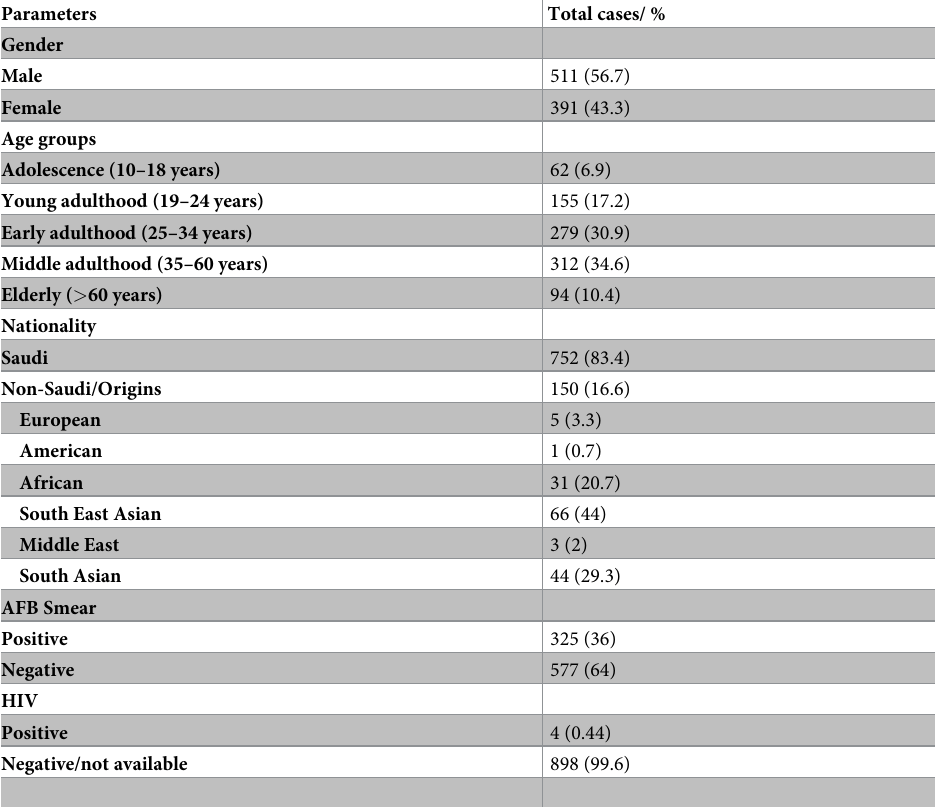
Table 1. Demographical and clinical summary of 902 EPTB